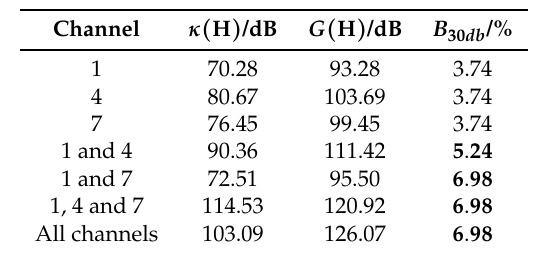
Table 1. Parameters of different